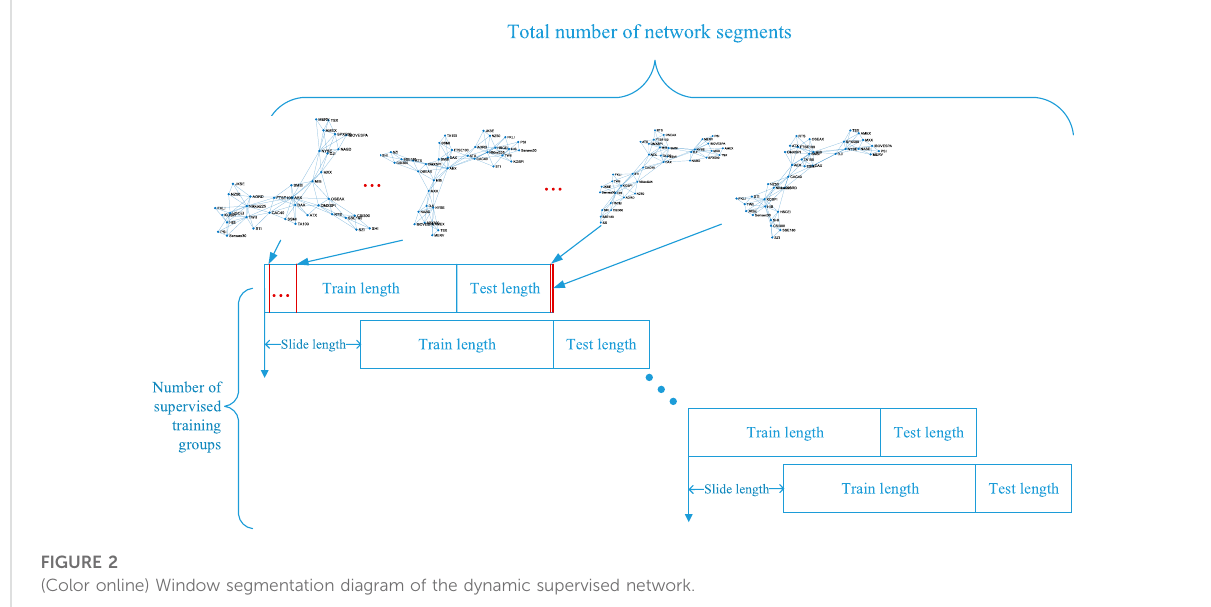
FIGURE 2 (Color online) Window segmentation diagram of the dynamic supervised network.